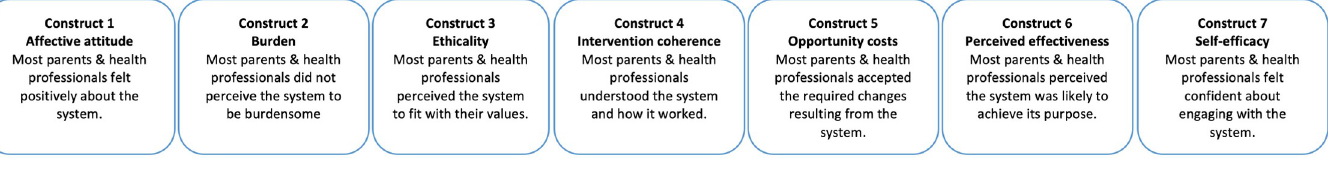
Fig 3. Domains of theoretical framework of acceptability (v2) as applied to